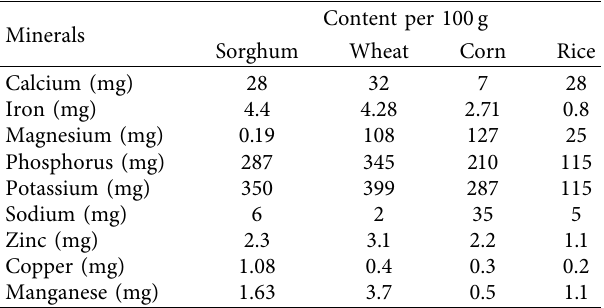
Table 3: Mineral content of Sorghum grain compared to other cereals,